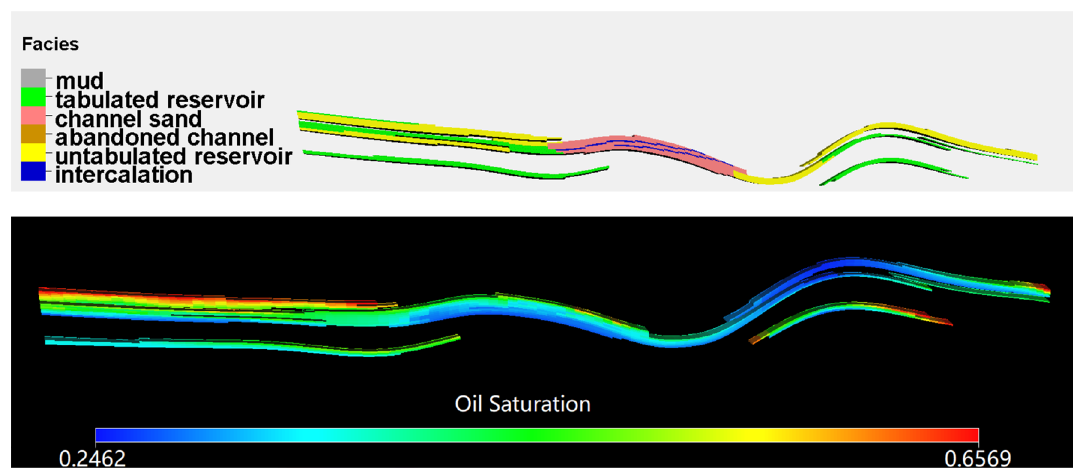
Fig. 11 The profile 2 of facies model and oil saturation simulation result in study area. a Profile 2 of facies model; b profile 2 of oil saturation simulation result set in study area